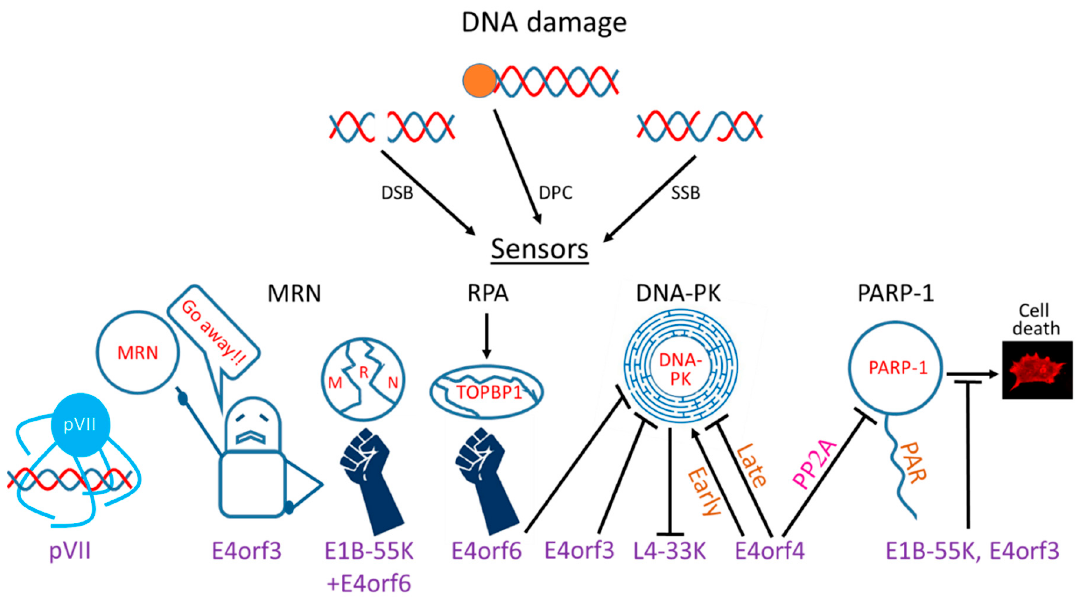
Figure 1. Interactions of adenovirus (Ad) proteins with DNA damage response (DDR) system components. Three types of DNA damage related to Ad infection are shown (DSB: double-strand breaks, SSB: single-strand breaks, DPC: DNA–protein crosslinks). The e ff ects of several Ad proteins involved in the interaction with the DDR are shown in cartoon form. pVII: protein